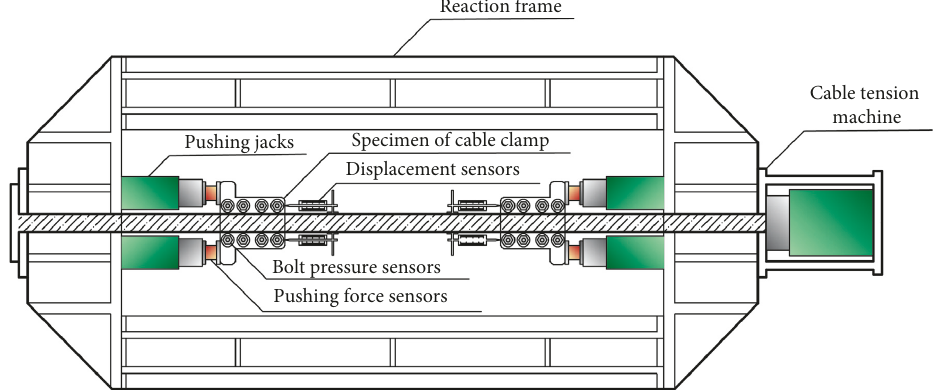
Figure 8: Real-time monitoring test system for cable clamps.